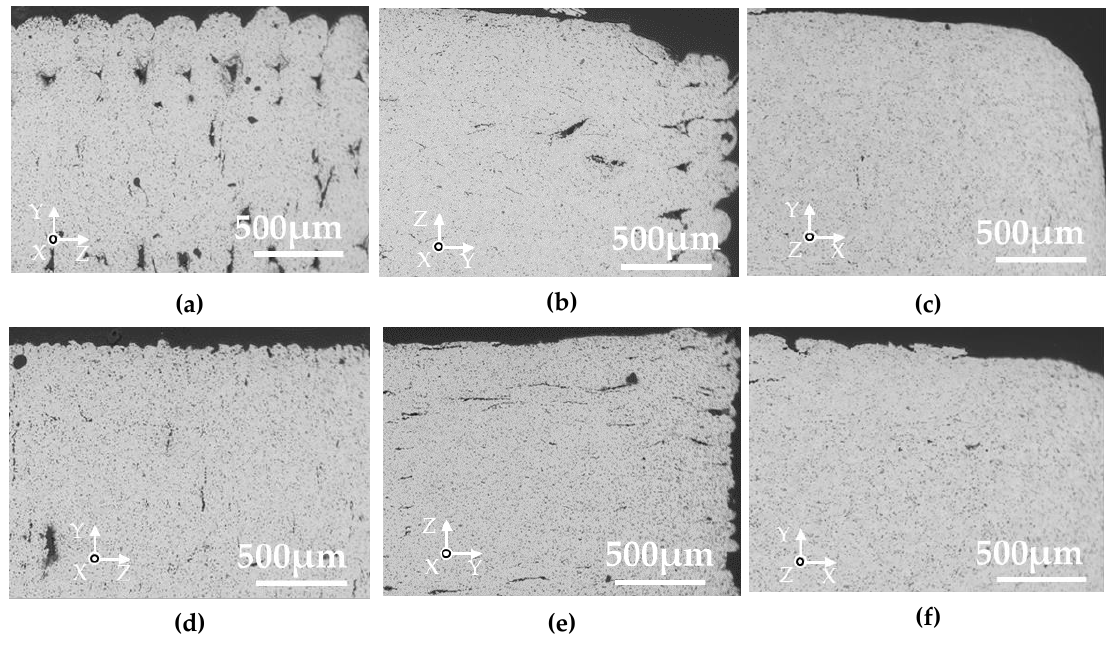
SEM micrographs of cross-sections perpendicular to the length of the silver parts. ( a ) W-specimen, thickness 0.3 mm; ( b ) T-specimen, thickness 0.3 mm; ( c ) L-specimen, thickness 0.3 mm; ( d ) W-specimen, thickness 0.1 mm; ( e ) T-specimen, thickness 0.1 mm; ( f ) L-specimen, thickness 0.1 mm.